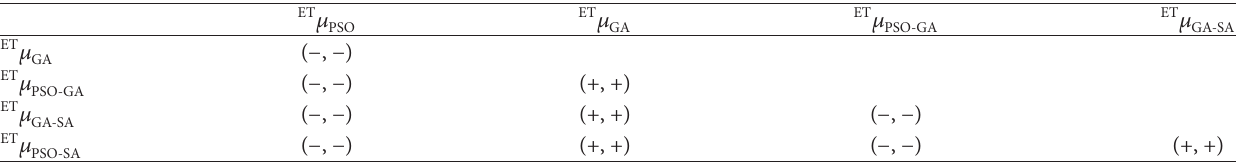
Table 6: Multiple comparison on execution time.